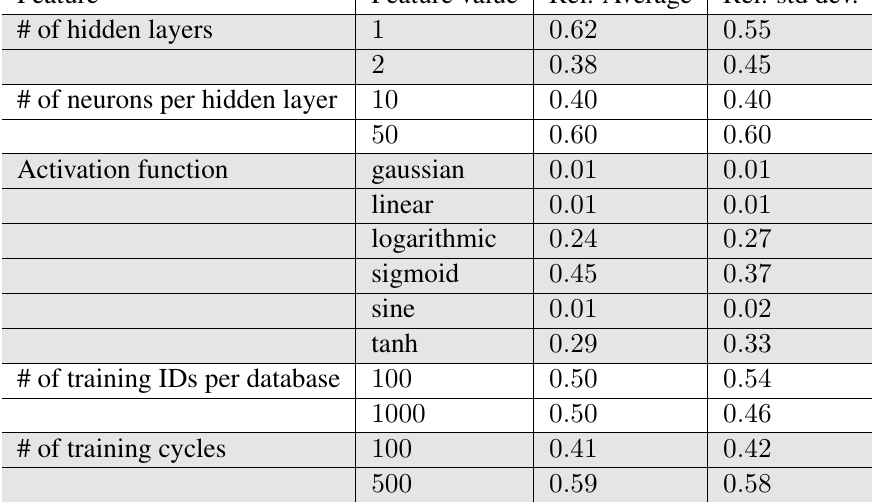
Table 3: Evaluation of five variables for the training and design of neural networks. In the first column, we list the five variables. In the second column, we list the applied values for each vari- able by quantity or lexicographically. In the third and forth column, we present the average and standard deviation of the evaluation score of equation (1) normalized to a sum of 1 within each variable category and rounded to two positions after the decimal point.